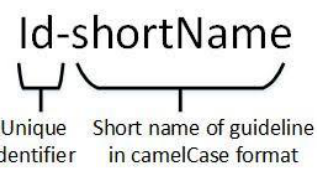
Figure 4. Naming convention applied while describing classes of usability guidelines in the ontology